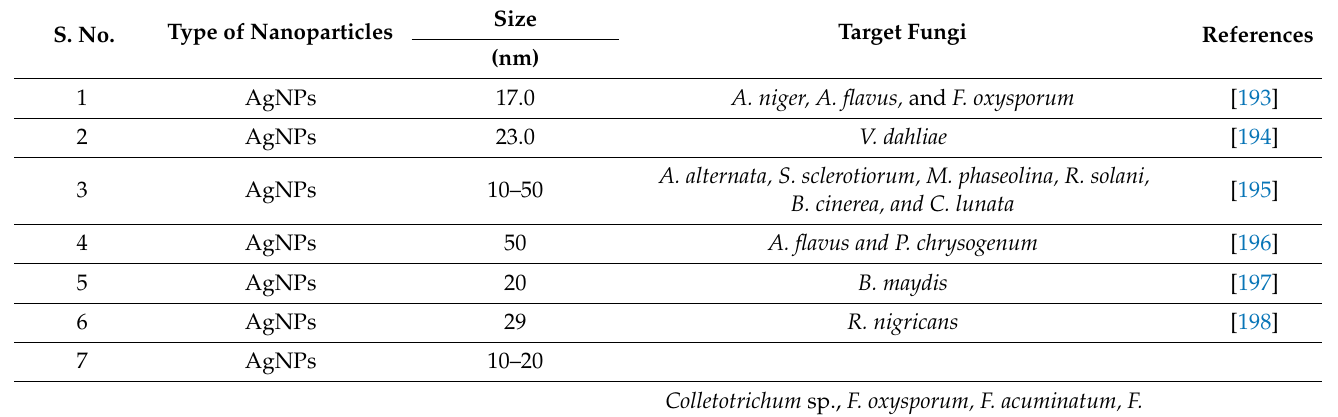
Table 1. Antifungal effects of various types of